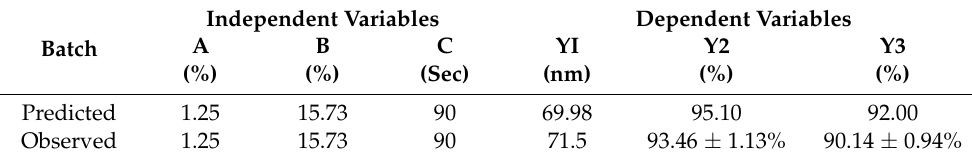
Table 4. Predicted optimized formulation by design along with experimental results.